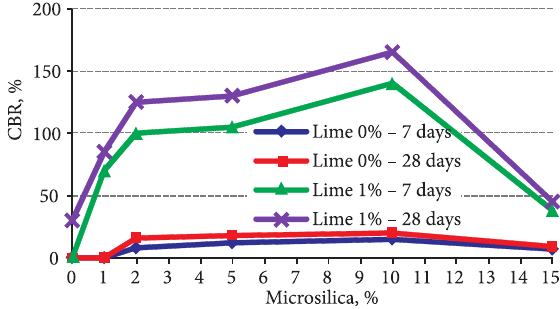
Fig. 6. Effect of adding Microsilica-Lime on CBR with 30 blows for 0% and 1% Lime in saturated conditions